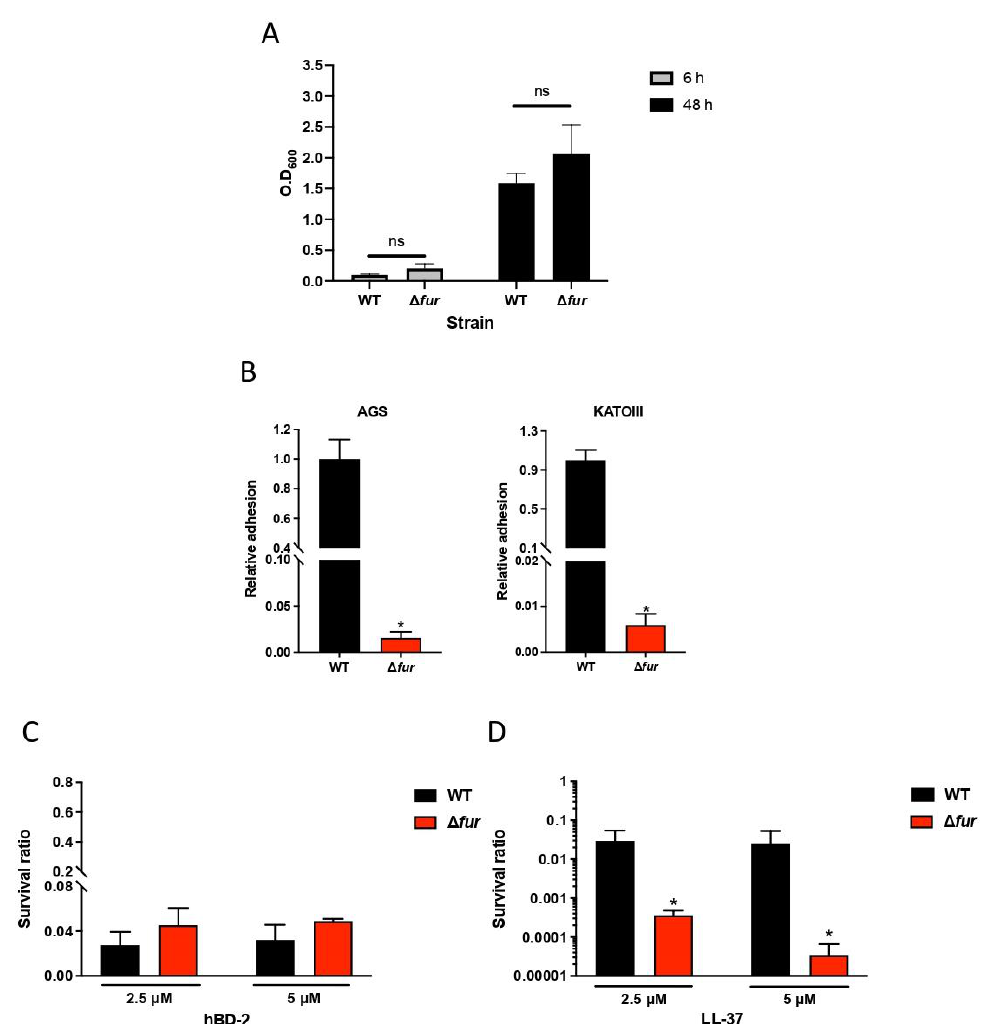
Figure 6. Survival of H. pylori and ∆ fur in the presence of antimicrobial peptides. ( A ) Growth of H. pylori WT and the ∆ fur mutant in medium BB10 over time was measured by OD 600nm at 6 h and 48 h of incubation. Data are represented as the mean ± standard deviation from three independent experiments. ( B ) Attachment of H. pylori wild-type and the ∆ fur mutant to human epithelial gastric cells. Attachment to the gastric epithelial cell lines AGS (left panel) and KATO-III (right panel) of H. pylori at an MOI of 100 for 2 h. Unbound bacteria were removed by washing, and the adherent H. pylori were determined by serial dilution and plating. Data represent the relative adhesion ratio to the wild-type from three independent experiments with duplicate samples. The error bars represent the standard error of the mean. * p < 0.05, ns: non-significant. ( C ) The H. pylori wild-type and ∆ fur mutant strains were incubated with hBD2 (2.5 or 5 μM) or ( D ) LL-37 (2.5 or 5 μM) for 2 h at 37 °C. Viable counts were determined by serial dilution and plating. The survival ratio is expressed relative to the untreated control. Data are presented as the means ± SD from three independent experiments. * p < 0.05.